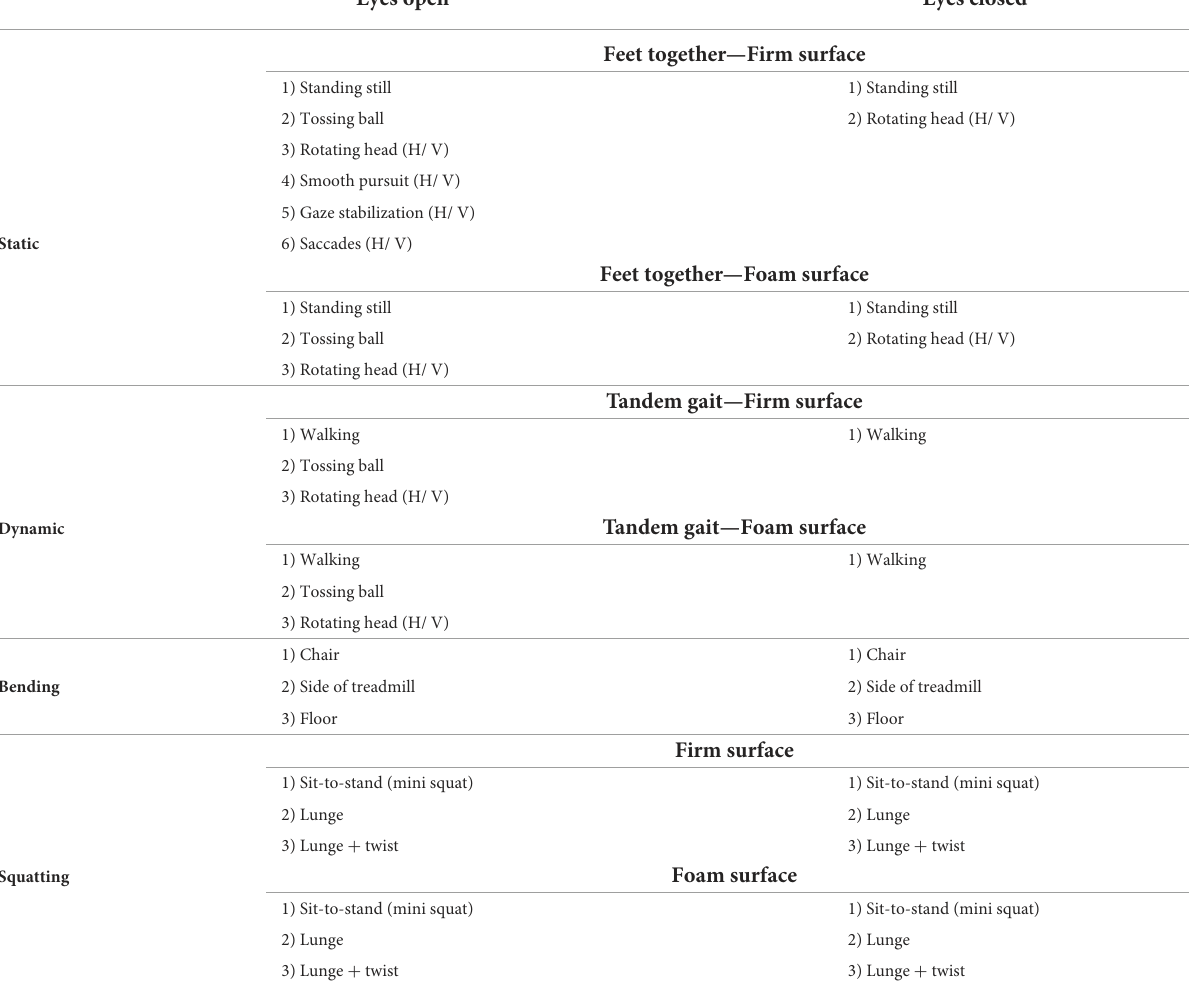
TABLE 2 Exercises performed during vestibular rehabilitation sessions for with and without ABF